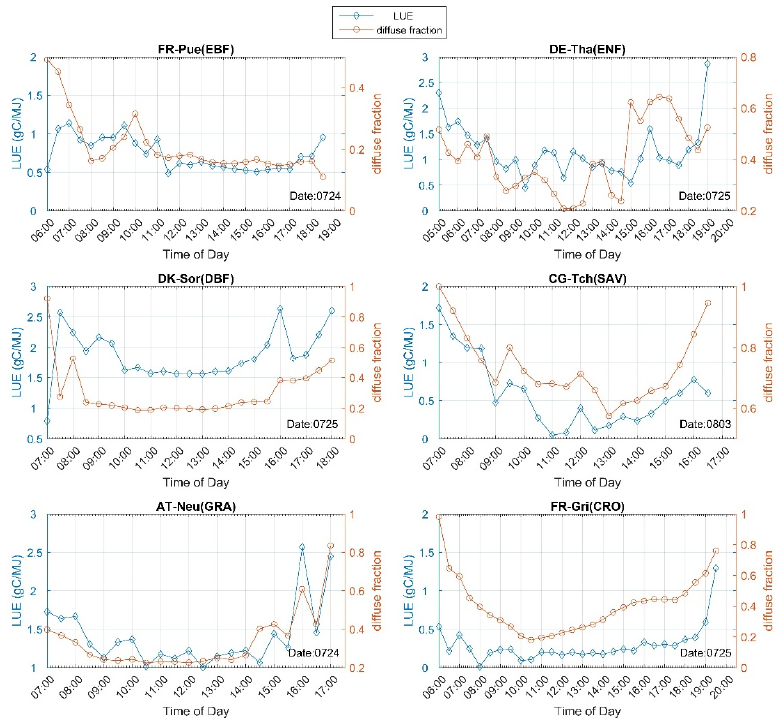
Figure 1. Diurnal variations of LUE and diffuse fraction at FLUXNET sites. In addition, the relationship between LUE and diffuse fraction was examined across the FLUXNET sites within the whole year (Figure 2). For a better analysis, we firstly di- vided the diffuse fraction into ten levels from the lowest to the highest values (0.1 inter- vals). The results showed that LUE increased with increasing diffuse fraction for all veg- etation types, which indicated the significant enhancement effect of diffuse radiation to- ward LUE [28,29].